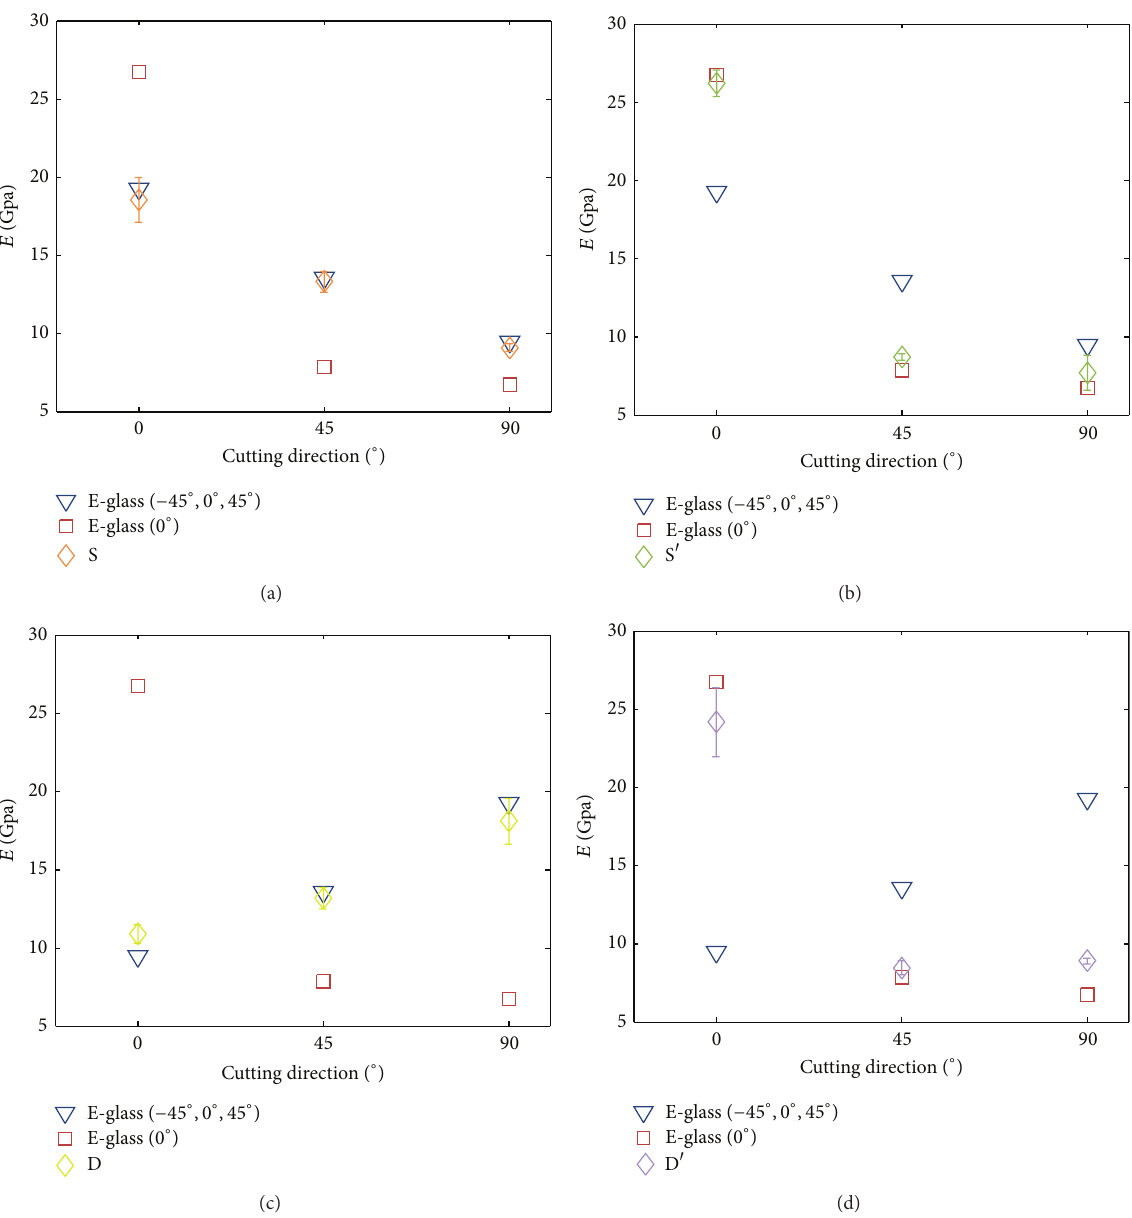
Figure 10: The equivalent elastic moduli of the 4-layer fiberglass composite strips made by the mixed E-glass (− 45 ∘ , 0 ∘ , 45 ∘ ) and the E-glass ( 0 ∘ ) in four different layer configurations (S, S 󸀠 , D, D 󸀠